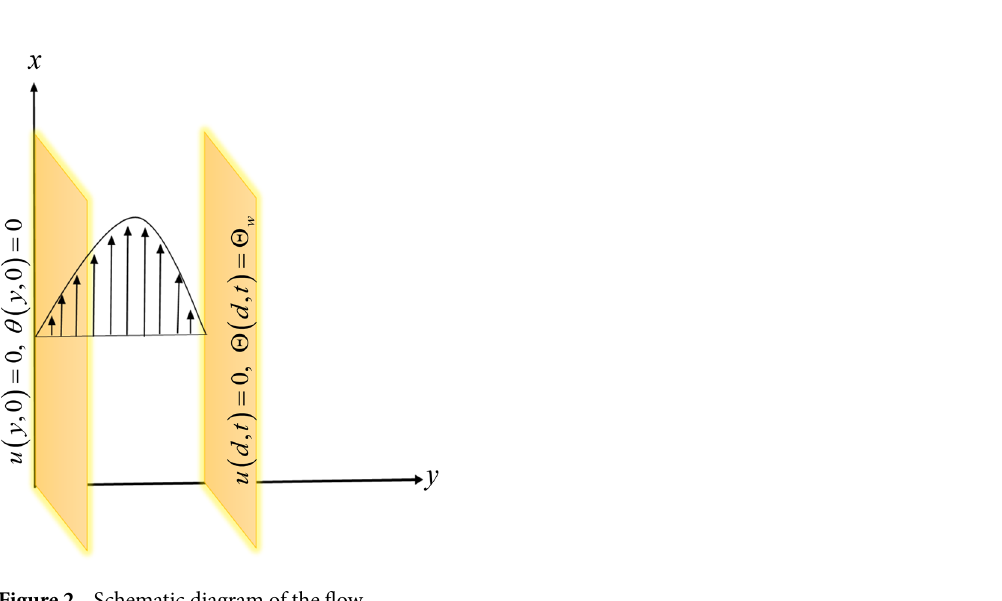
Figure 1. Schematic representation of the drilling process.